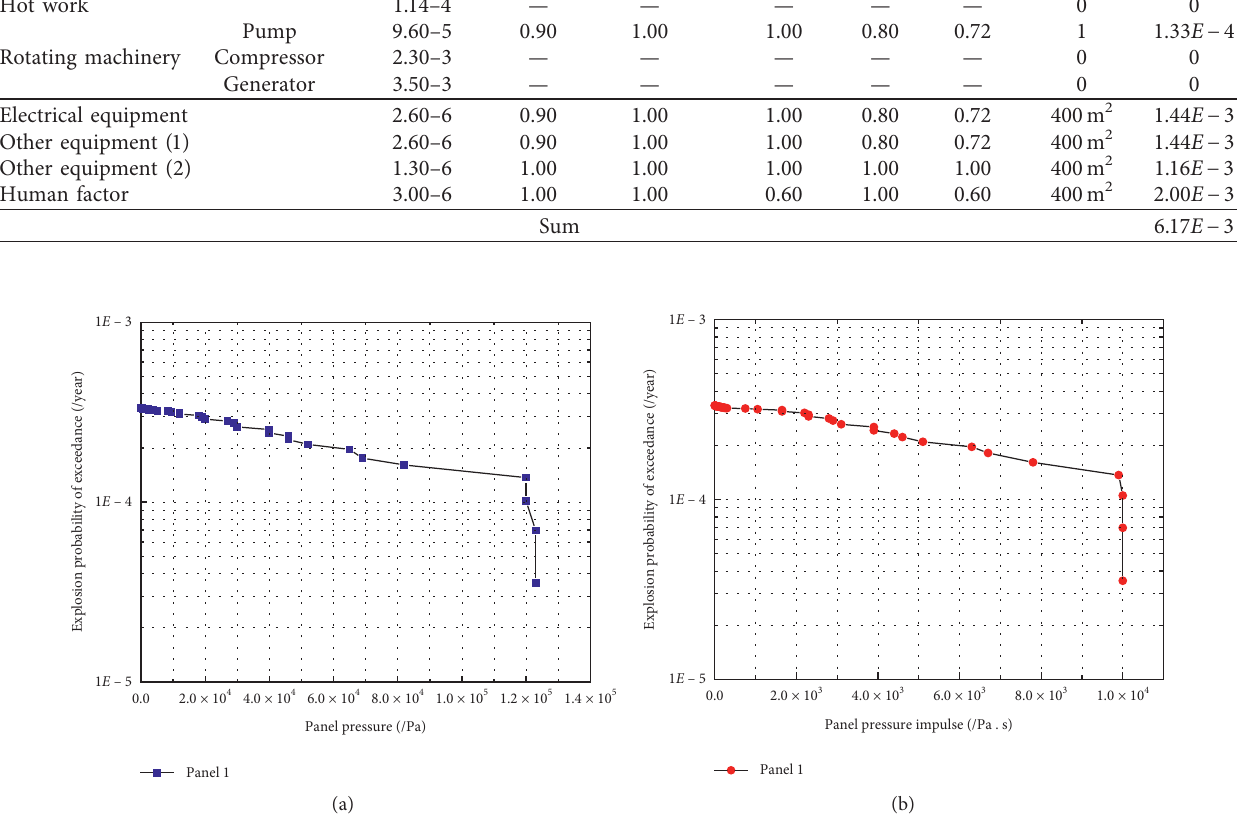
Figure 29: Pressure (a) and impulse (b) exceedance probability curves of a panel of example platform. Table 8: Suggested explosion load design values in